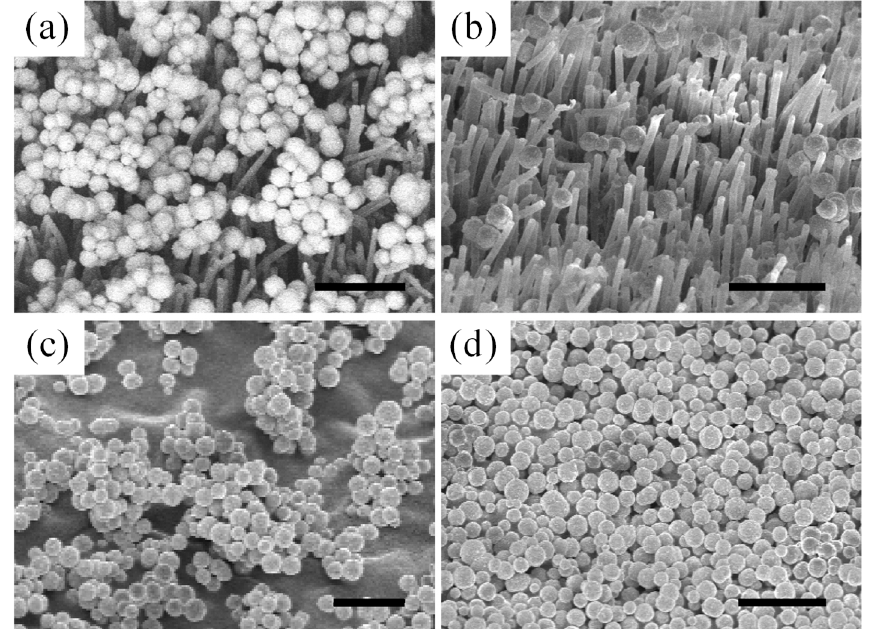
Figure 16. ( a ) Micro fiber adhesive contaminated with gold microspheres. ( b ) Micro fiber adhesive after 30 contacts (simulated steps) on a clean glass substrate. Some of the microspheres were trapped inside the micro fibers. ( c ) Conventional pressure sensitive adhesive (PSA) surface contaminated with microspheres. ( d ) PSA surface fully covered by the Au microparticles after the same simulated steps. Reproduced with permission from [153], published by ACS Publications, 2008.